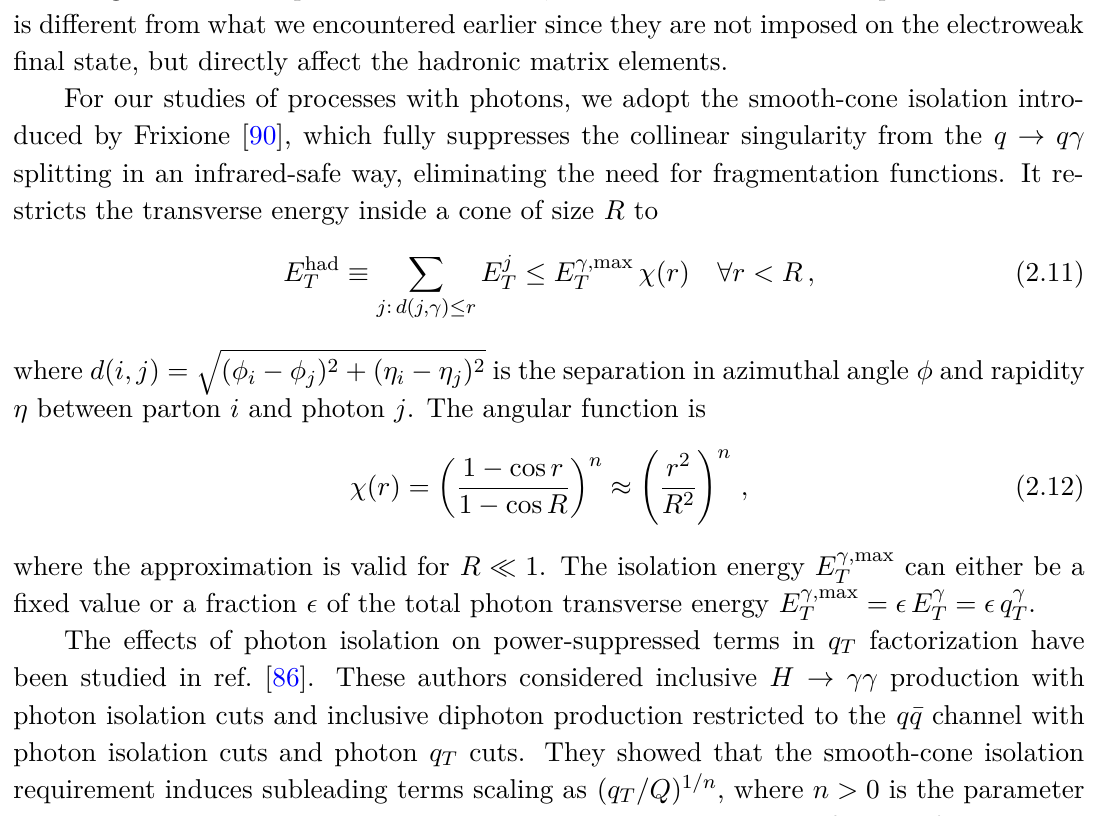
Figure 2. Power-suppressed matching corrections for pp → H → γγ (left) and pp → γγ (right). For diphoton production only the u ¯ u channel is shown, with cuts q γ We plot results for the values n = 0 . 5 , 1 , 2 of the isolation parameter n . Power corrections not from photon isolation are shown as purple and blue lines. The dashed lines show the scaling ( q T /Q ) 1 /n derived in ref.